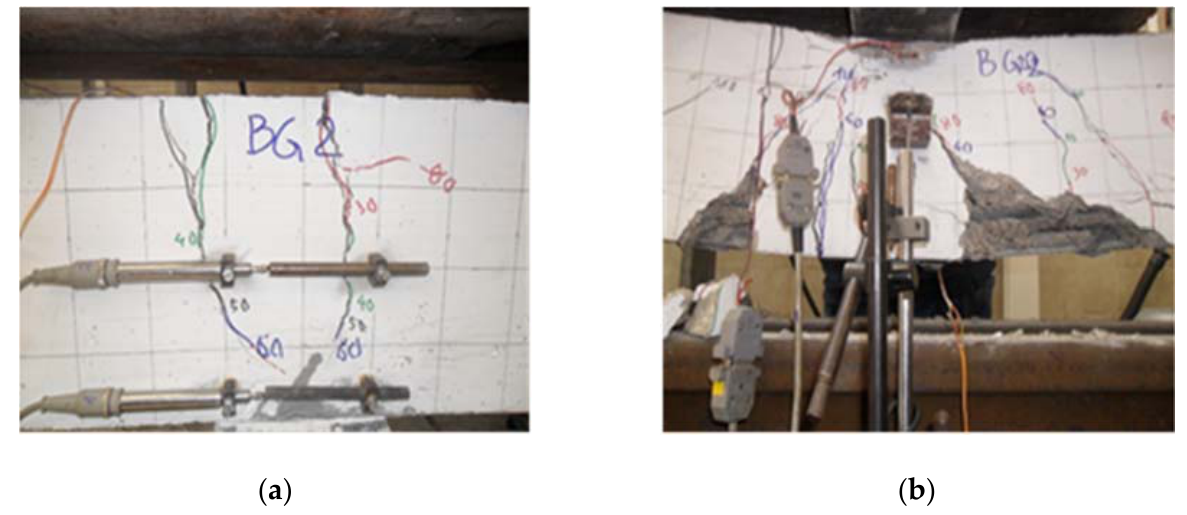
Figure 18. Beam B-G2: ( a ) Failure of the cross section above the support; ( b ) Failure of cross section in the span due to concrete separation.